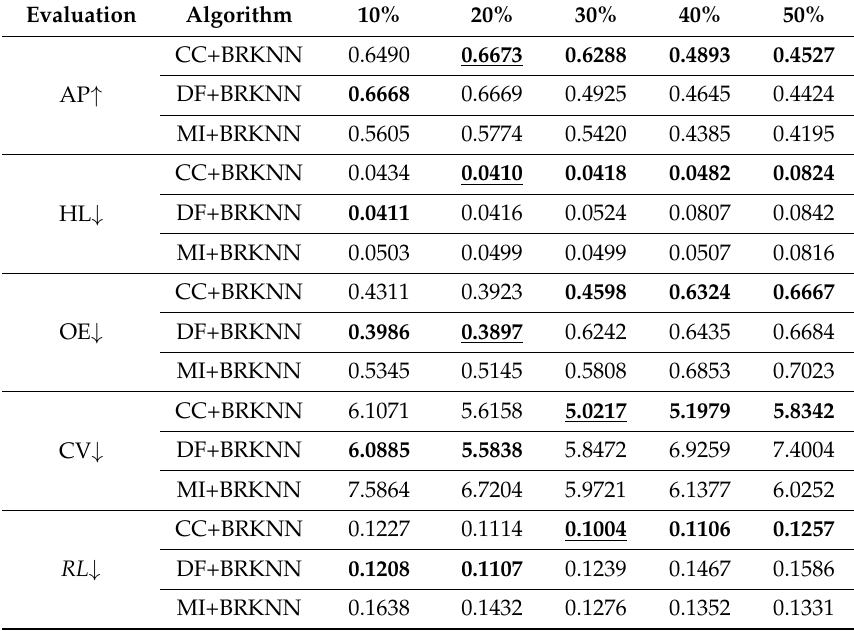
Table 13. Comparison of classification performance on Health data